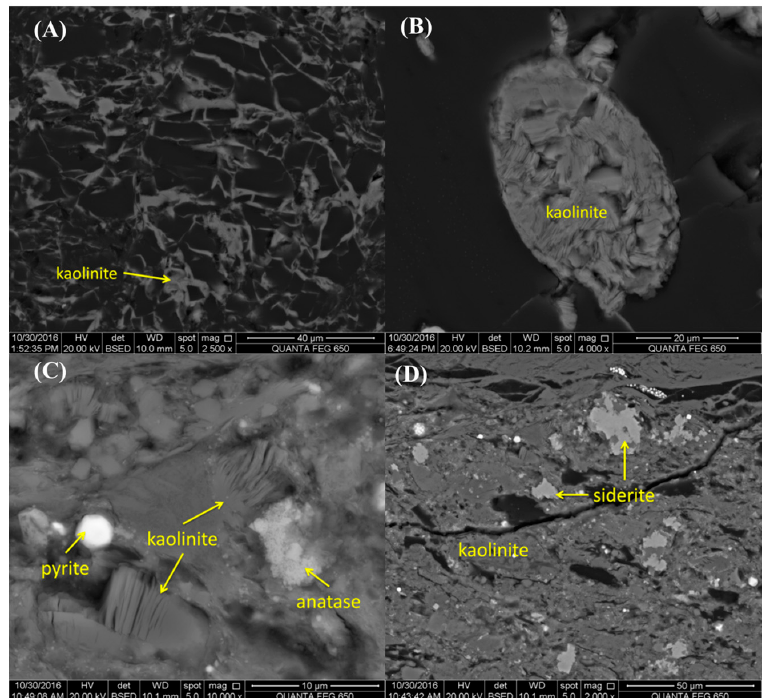
Figure 13. Kaolinite in Shugentian coal and non-coal samples, ( A , B ) Fissure-infilling and cell-infilling kaolinite in SGT1-9 sample; ( C ) book-like kaolinite in SGT1-11 sample; ( D ) kaolinite occurs as matrix of other minerals (siderite, pyrite and anatase) in SGT1-11 sample. SEM back-scattering images.